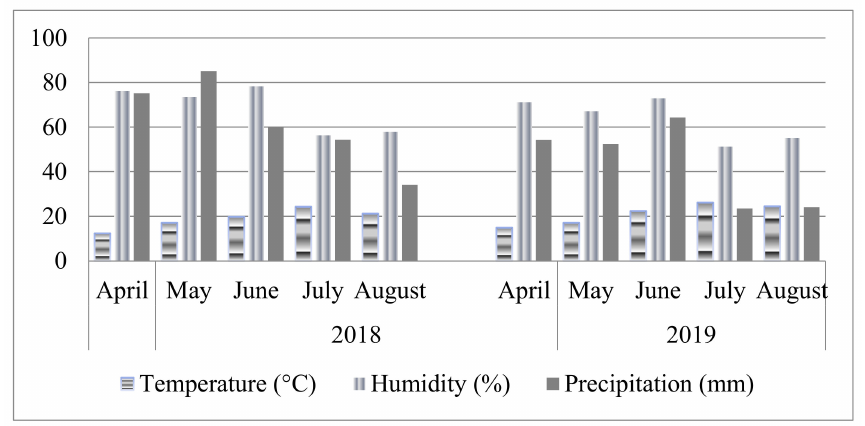
Figure 1. Average values of environmental